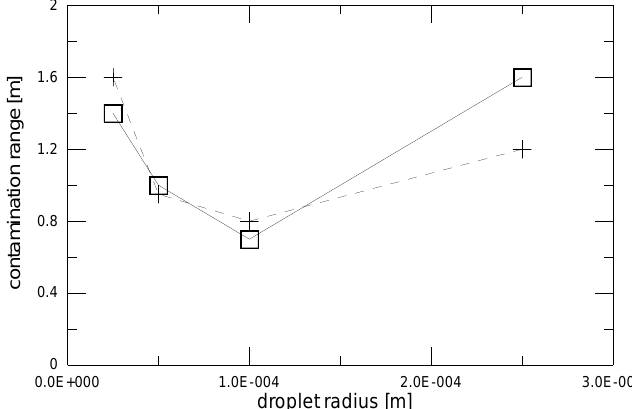
Figure 2. The contamination range for the present model, with evaporation suppressed and entrainment parameter β = 0.2 (squares) compared with some results from [4] (crosses) within the common range of the droplet sizes (connection lines are added to help visualization only).